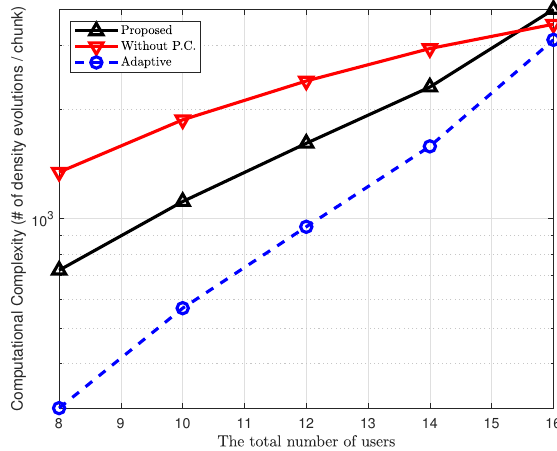
Figure 15. Computational complexity with and without power control; the number of iterations is